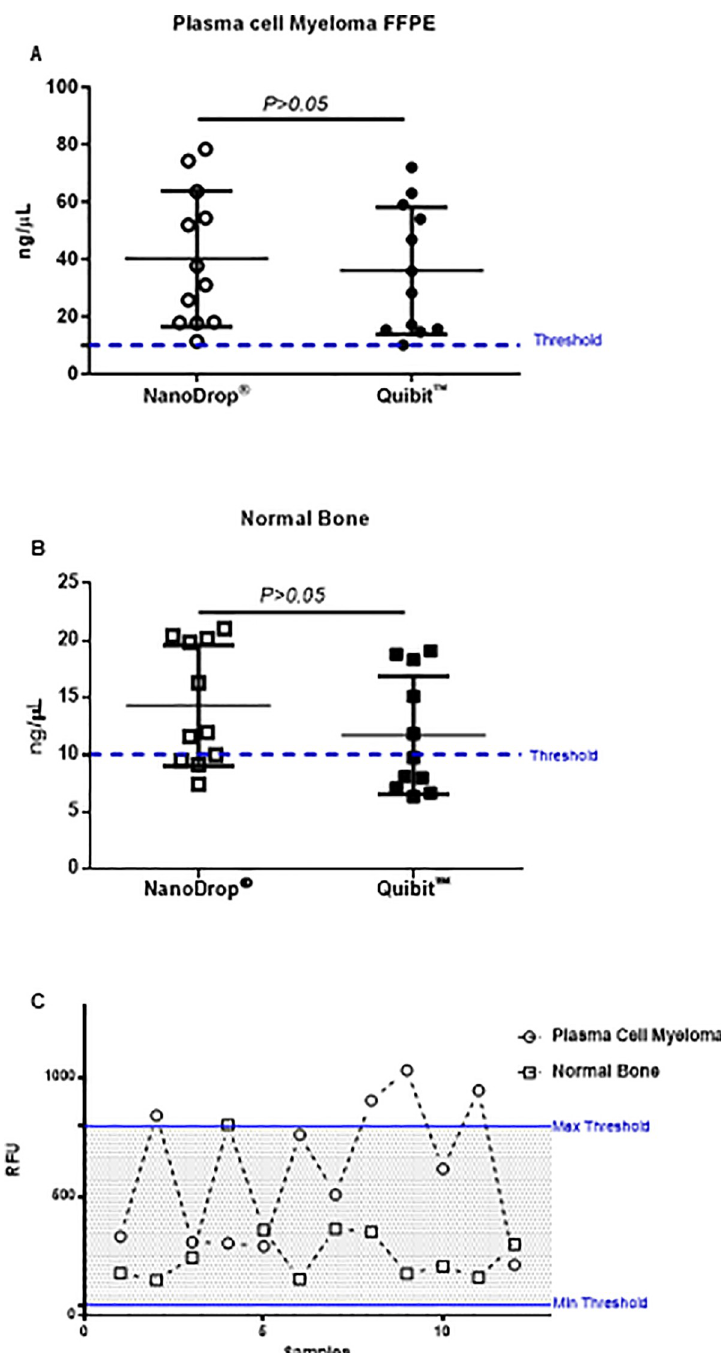
Fig 3. Comparison of mRNA yield from DFFPE of MM and normal bone tissue using NanoDrop 1 vs. Qubit TM . (A) Scatter-dots plot indicating quantification of mRNA concentration yield from DFFPE of MM by using NanoDrop 1 and Qubit TM 2 Fluorometer. n = 12 for in each group. Data were analyzed by Student’s t test (p > 0 . 05) and shown as means ± SD. (B) Scatter-dots plot indicating quantification of mRNA concentration yield from DFFPE of normal bone tissue by using NanoDrop 1 and Qubit TM 2 Fluorometer. n = 12 for in each group. Data were analyzed by Student’s t test (p > 0 . 05) and shown as means ± SD. Threshold lines in plot A and B (dashed lines) indicated the minimum required mRNA concentration (~10 ng/ μ L) for gene expression assay by NanoString TM (C) Scatter-Line plot using Qubit TM 2 Fluorometer representing relative fluorescence emission (RFU) of mRNA extracted from DFFPE of normal bone tissue and MM. lines indicates the threshold for minimum and maximum RFU value.